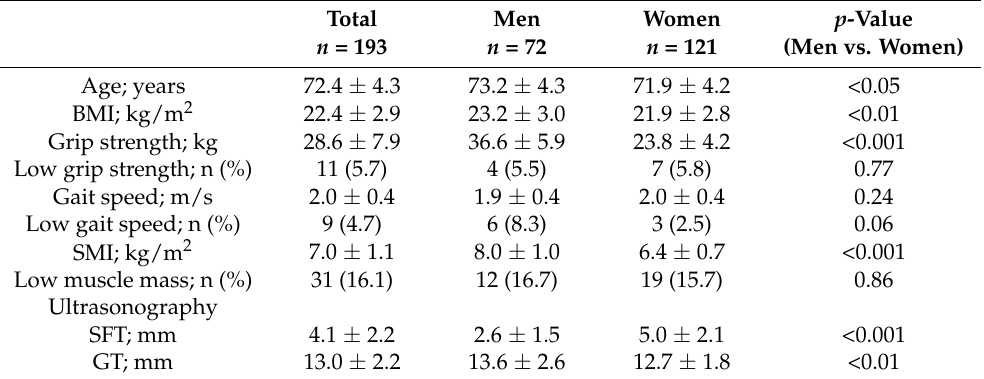
Table 1. Characteristics of participants.